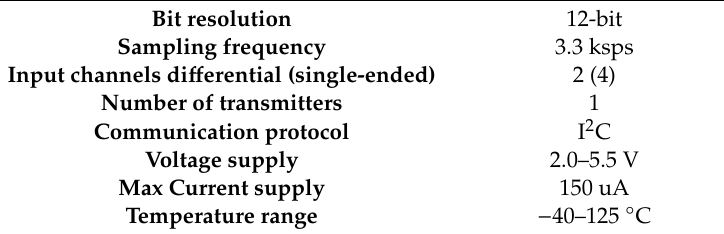
Figure 7. A 3D view of the ADC module: ( a ) front side; ( b ) back side. Table 5. Main features of the ADS1015 chip used in the ADC